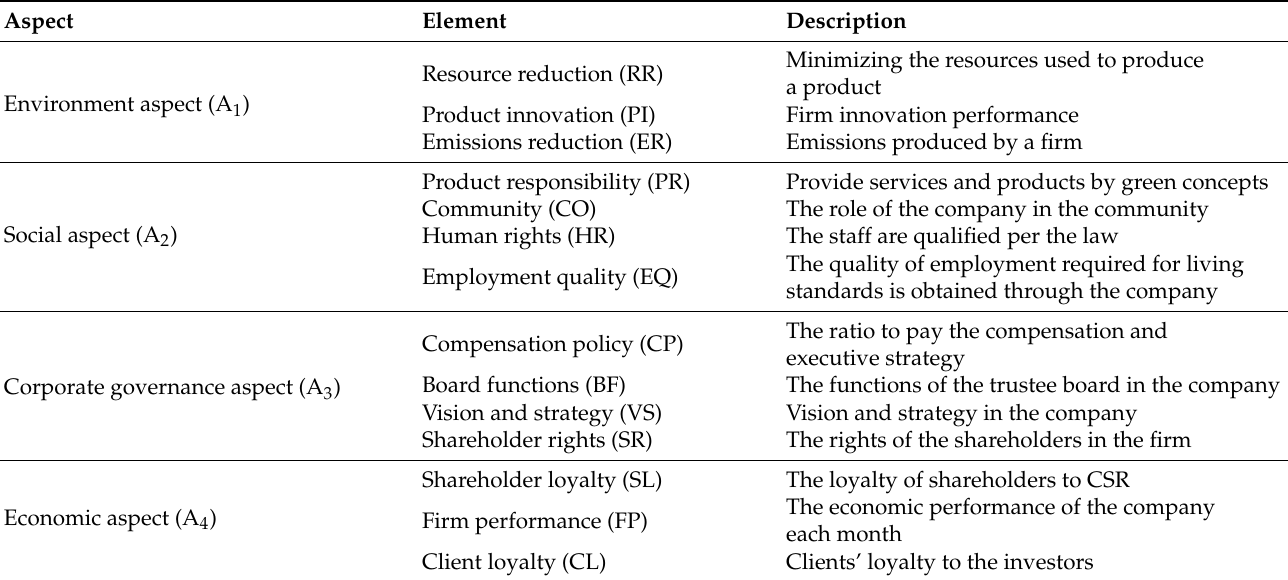
Table 1. CSR measurement